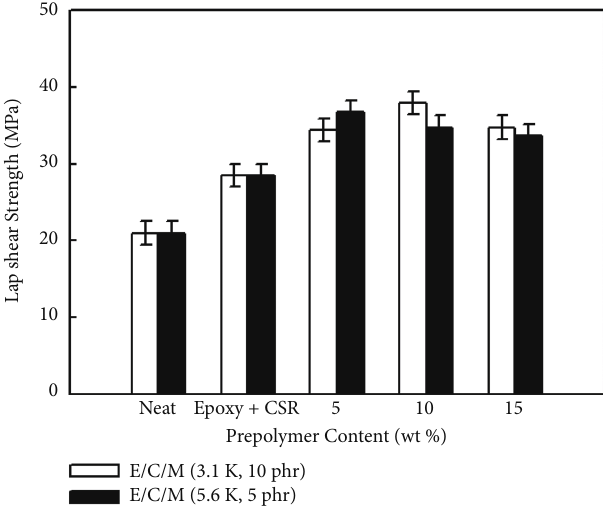
Figure 3: Comparison plot of lap shear strength between E/C/M (3.1 K) and E/C/M (5.6 K) epoxy resins using di ff erent MPB wt%.